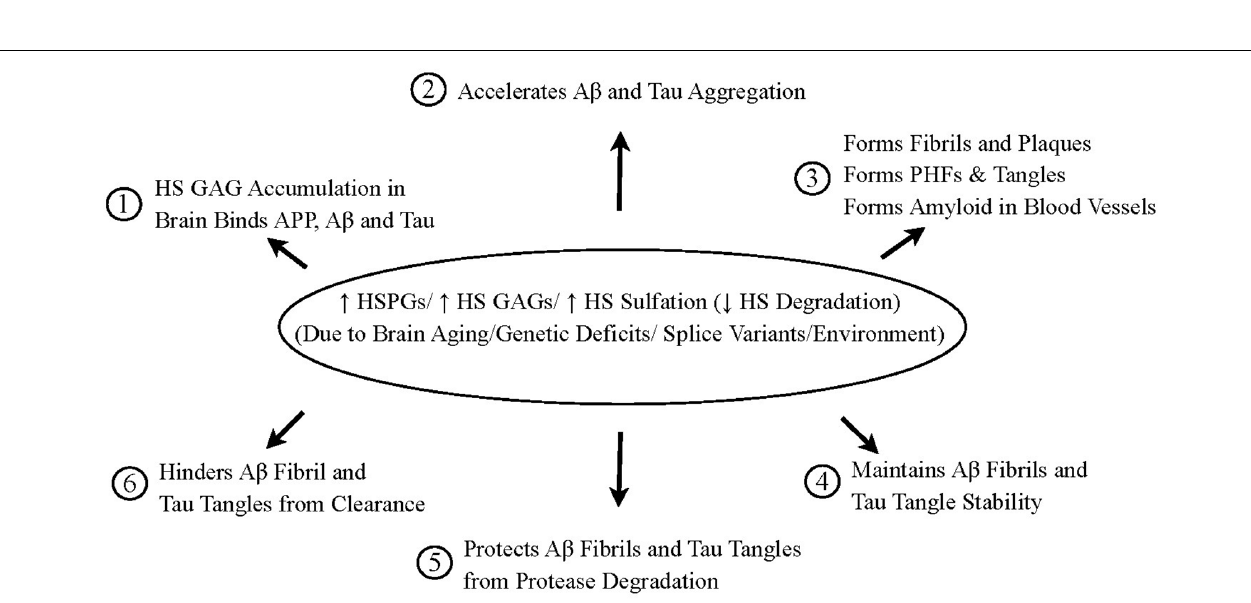
FIGURE 10 | HSPGs and HS GAGs initiate and cause the brain pathology of AD. ↑ HSPGs (perlecan, agrin, glypicans, syndecans, undiscovered HSPGs)/ ↑ HS GAGs/ ↑ HS sulfation and/or ↓ HS degradation in the brain (in neurons, microglia, astrocytes, and/or endothelial cells) is postulated to occur due to: (a) brain aging, (b) genetic deficits; (c) splice variants; and/or (d) environment. All of these possibilities lead to increased HS GAGs and/or increased sulfation of HS GAGs. This then leads to: (1) increased binding to beta-amyloid precursor protein (APP), beta-amyloid protein (A β ), and tau protein; (2) acceleration of A β and tau protein aggregation; (3) formation of A β amyloid fibrils, spherical maltese-cross amyloid plaques, and neuritic plaques; formation of paired helical filaments and tangles; and formation of A β amyloid deposits in blood vessel walls; (4) maintenance of A β amyloid fibril and tau tangle stability; (5) protection of A β fibrils and tau tangles from protease degradation; and (6) hindrance and blocking of the clearance of A β fibrils and tau protein tangles from the brain. This leads to the formation and persistence of brain plaques, tangles, and cerebrovascular amyloid, as well as increasing neuroinflammation all causative for the observed pathology in the AD brain. AD should be examined and tested to form new therapeutics like a mucopolysaccharidosis disorder since similar consequences (i.e., formation of congophilic and Thioflavin S-positive neuronal inclusions; increased deposition of A β ; increased neuroinflammation; cognitive decline and eventual death) have all been observed in young children inheriting the lack of specific HS GAG degrading enzymes which usually leads to accelerated cognitive decline and early death.